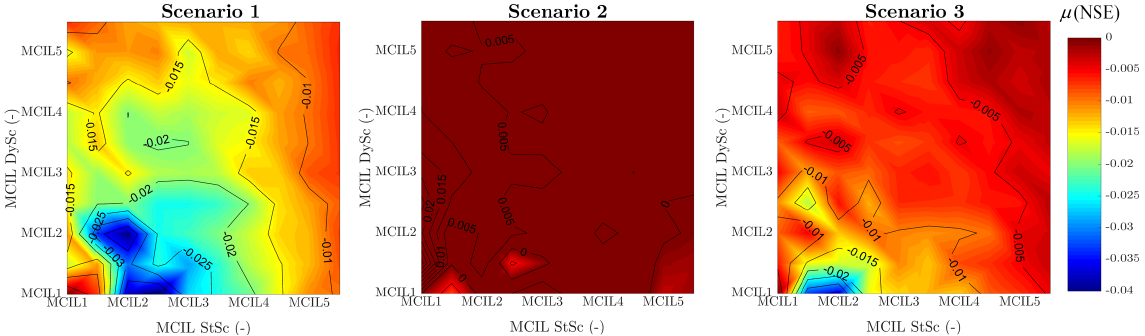
Figure 11. Difference between µ ( NSE ) values obtained considering standard and higher active citizen percentage in the municipality of Vicenza for different involvement levels from StSc and DySc.